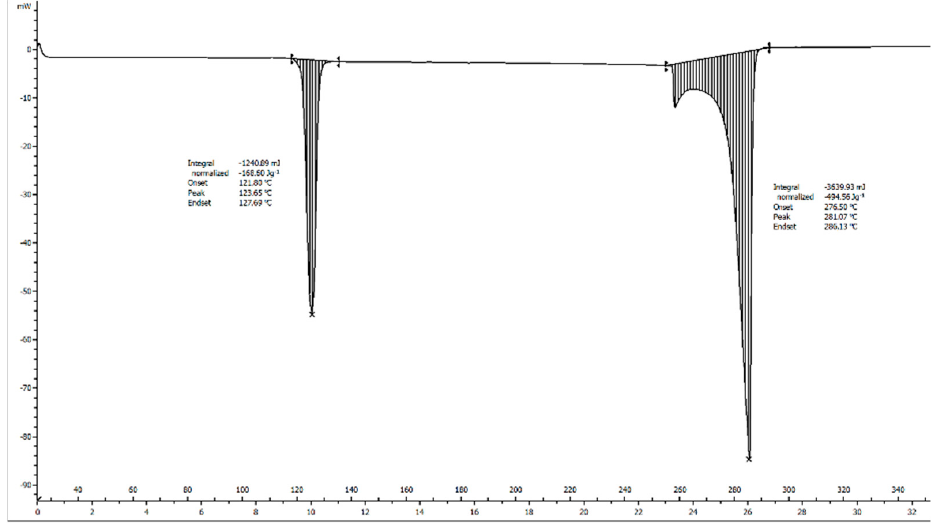
Figure A1. DSC thermogram of benzoic acid as original sample.